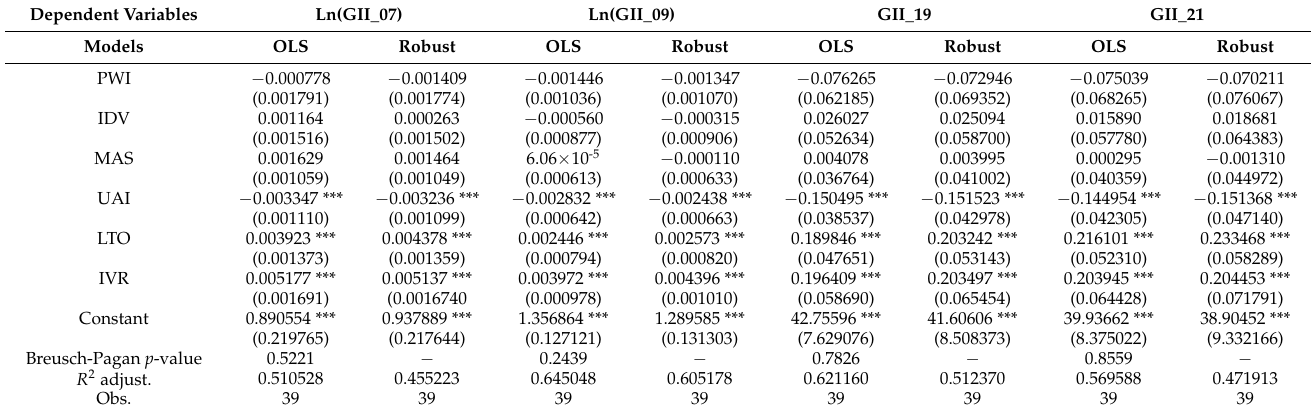
Table 6. A cross-sectional regression output (developed